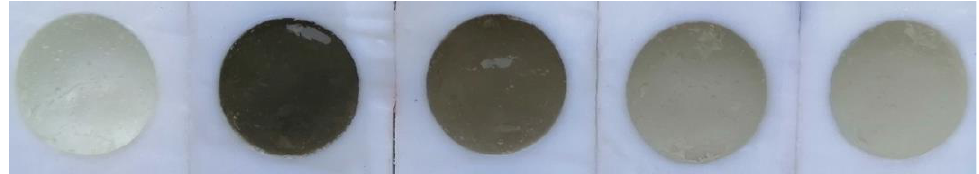
Figure 1. The initial hydrogel samples.